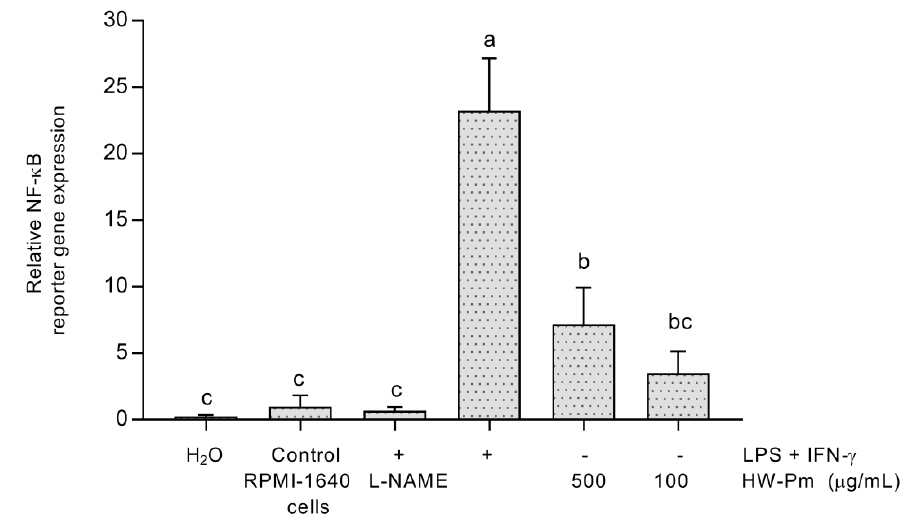
Figure 5. Effect of HW-Pm on NF- κ B activation. The assay was performed using a human monocytic cell line, stably transfected (U937-3xB-LUC reporter cell) with a luciferase reporter containing three NF- κ B-binding sites. LPS (100 ng/mL) and IFN- γ (5 ng/mL) were used as positive controls for stimulation. L-NAME was tested at 100 µ M. Means without the same letter are significantly different at the 5% level according to a one-way ANOVA test followed by a Tukey test ( n = 3).